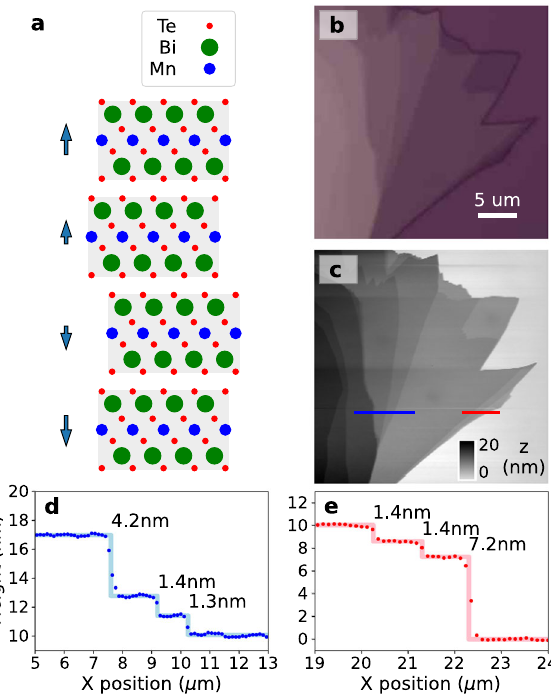
Fig. 1 Atomic force microscopy measurements. A simple diagram ( a ) of the atomic structure of MBT and the motion induced by the lowest-frequency interlayer breathing phonons for a 4-layer region of the sample. Optical ( b ) and AFM ( c ) images of a region of one of our exfoliated samples, along with cuts ( d , e ) showing various steps, which match well with the known ~1.4 nm layer